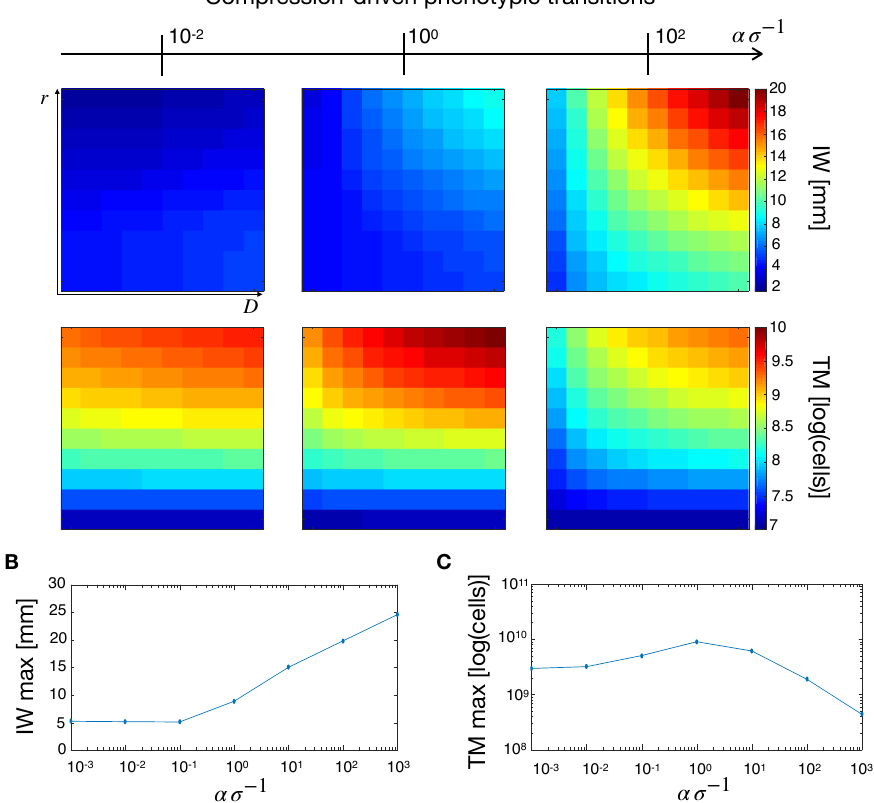
Figure 4. Tumor observables for mechanical-induced phenotypic switching. ( A ) Simulation maps of tumor IW and TM with respect to different values of effective stiffness ασ − 1 . From left to right σ = 10 5 ,10 3 ,10 1 Pa with α = 10 3 Pa. IW increases for increasing values of the α / σ ratio, whereas TM shows a maximum for intermediate values of effective stiffness. The maximum IW ( B ) and TM ( C ) are obtained for different values of effective stiffness, with α = 10 3 Pa, and σ varied. While IW shows an increasing trend with effective stiffness, TM displays an optimum for intermediate ασ − 1